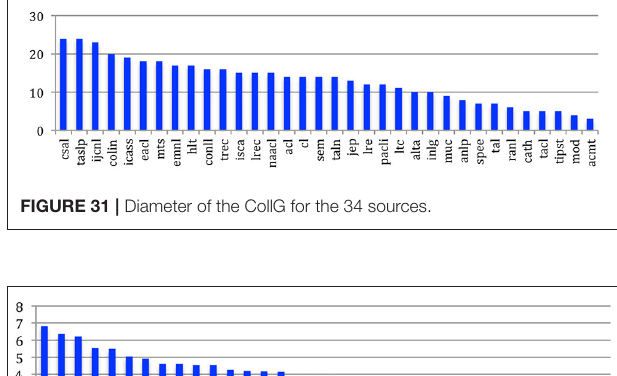
TABLE 5 | The 12 authors with the largest number of co-authors.